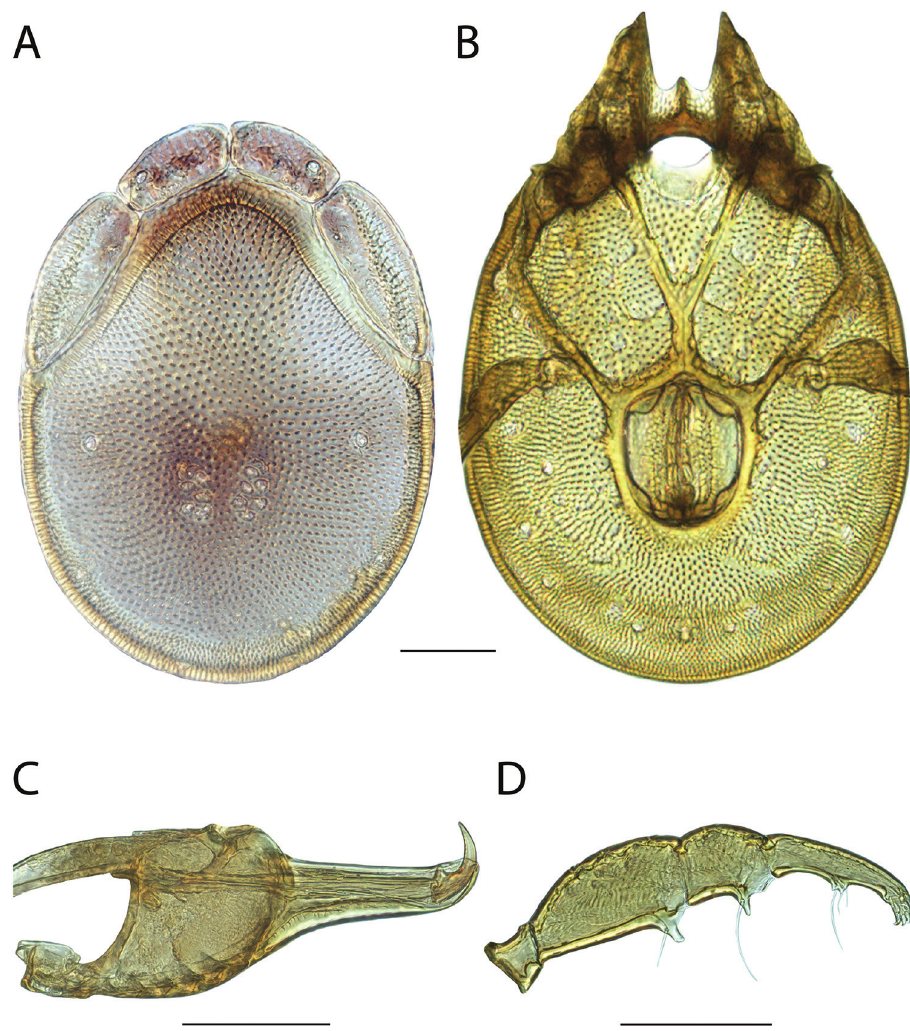
Figure 46. Torrenticola daemon sp. n. male: A dorsal plates B venter (legs removed) C subcapitulum D pedipalp (setae not accurately depicted). Scale = 100